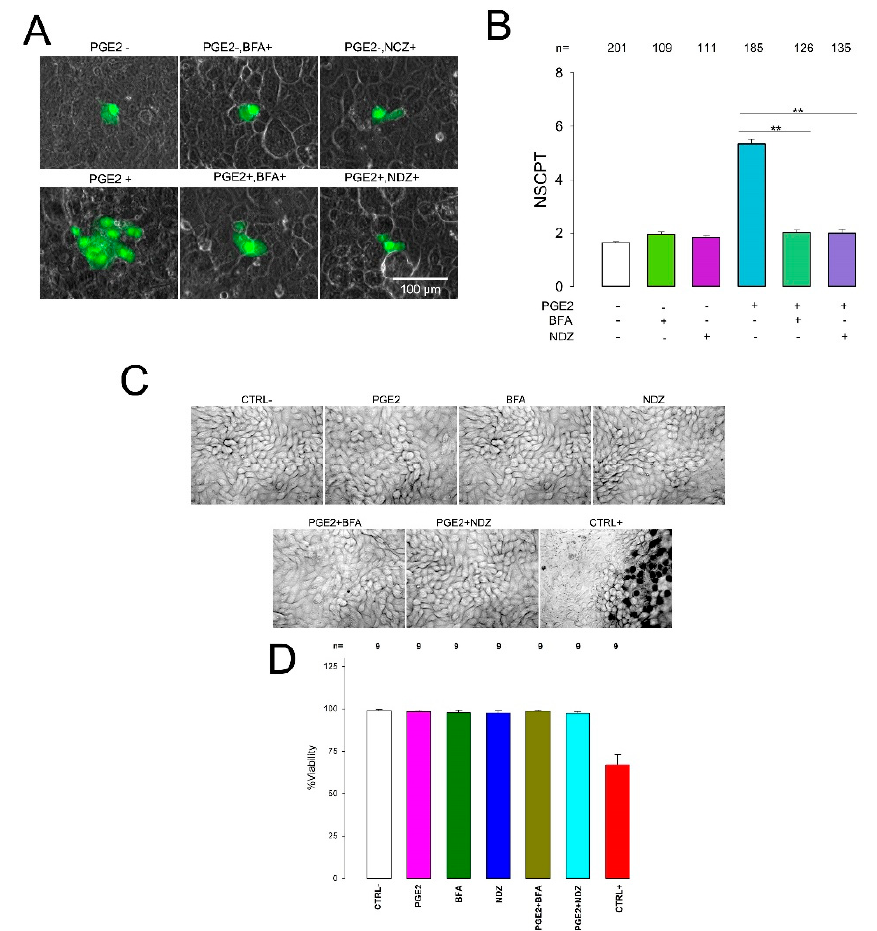
Figure 4. PGE2 promotes transport and relocation of gap junction components. ( A ) Representative images show clusters of cells stained (green) after one of them had been injected with Lucifer yellow. Each image was selected to match the median of the NSCPT obtained from a number of repeats under each experimental condition indicated. ( B ) The bar chart compares the mean NSCPT( ± SE) under each experimental condition indicated at the bottom of the bars. ( C ) Representative bright-field images and ( D ) bar chart comparing viability, by Trypan blue staining, of the different experimental conditions, including treatment with brefeldin A (BFA) and nocodazole (NDZ). ** Statistically significant difference ( p < 0.001) among the bars indicated by the lines. The numbers above bars indicate the number of repeats.